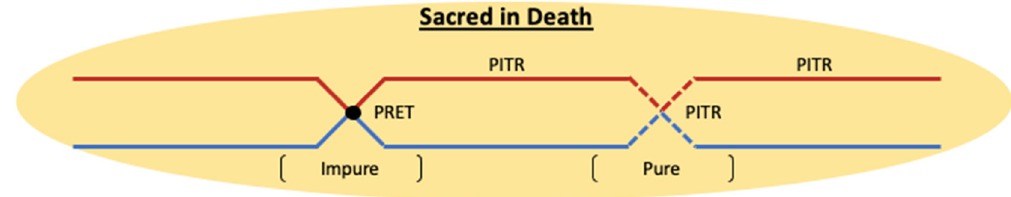
Figure 6: Pure and impure as a part of the sacred associated with death in